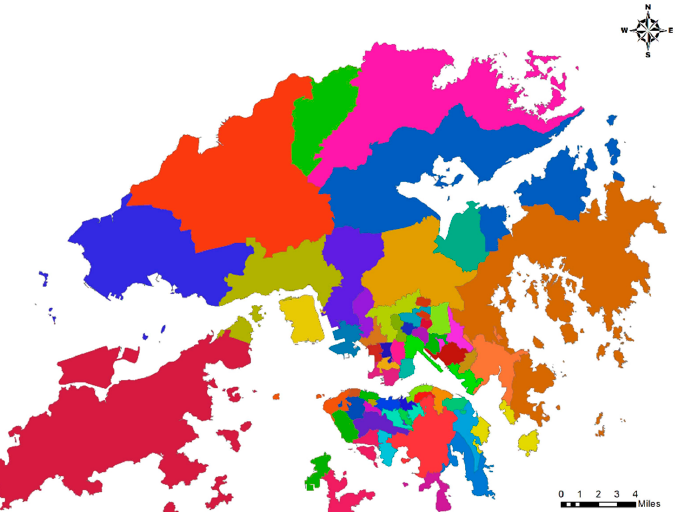
Figure A2. Hong Kong 52 Housing subdistricts categorized by Economic Property Research Centre